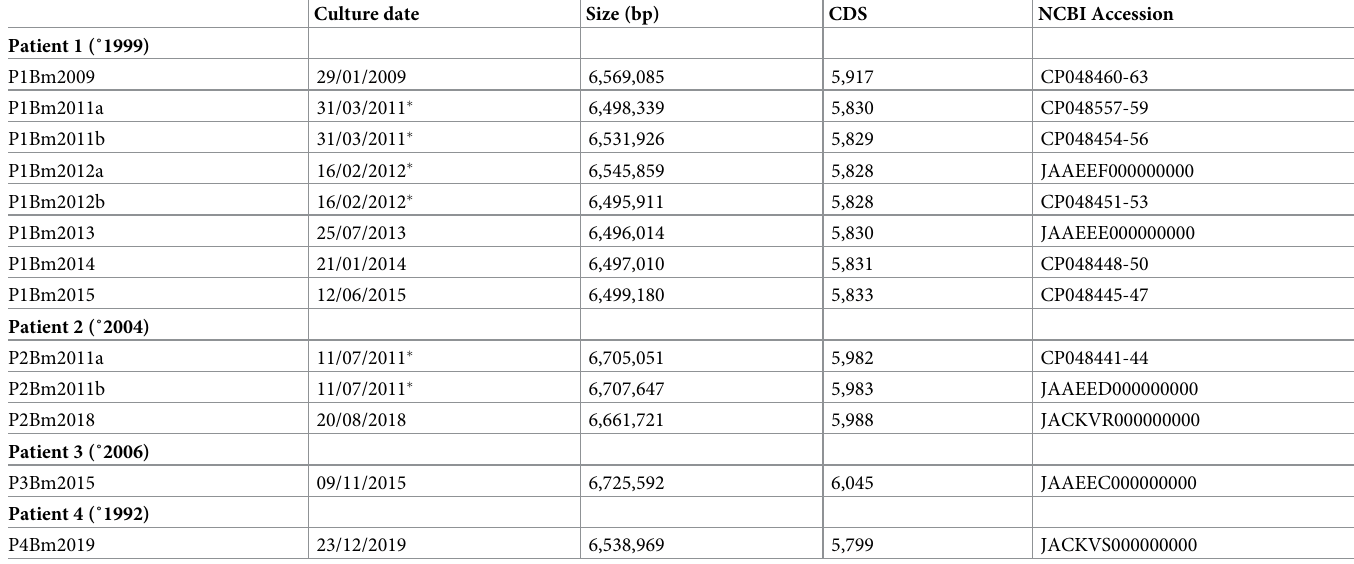
There are no other reports of ST-742 isolates in the Bcc PubMLST database [31]. Furthermore, MLST analysis of all publicly available B . multivorans genomes (Table D in S1 Tables) did not Table 1. List of isolates included in our study. Isolates marked with an asterisk were obtained from the same sputum sample but displayed distinct colony morphologies. Culture date Size (bp) CDS NCBI